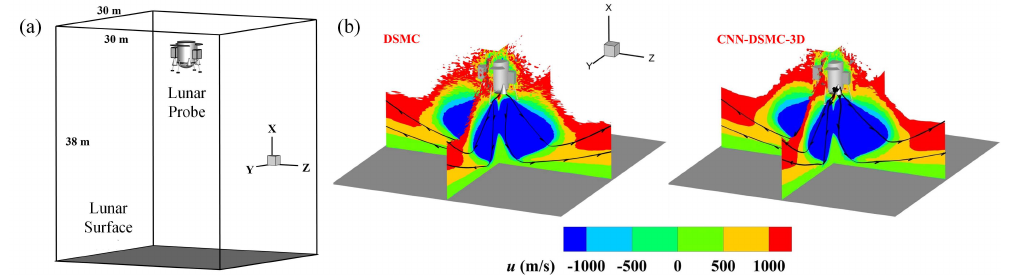
Figure 21. ( a ) Schematic of computational domain of the three-dimensional case. ( b ) The velocities at the altitude of h = 8.2 m obtained by the DSMC and CNN-DSMC